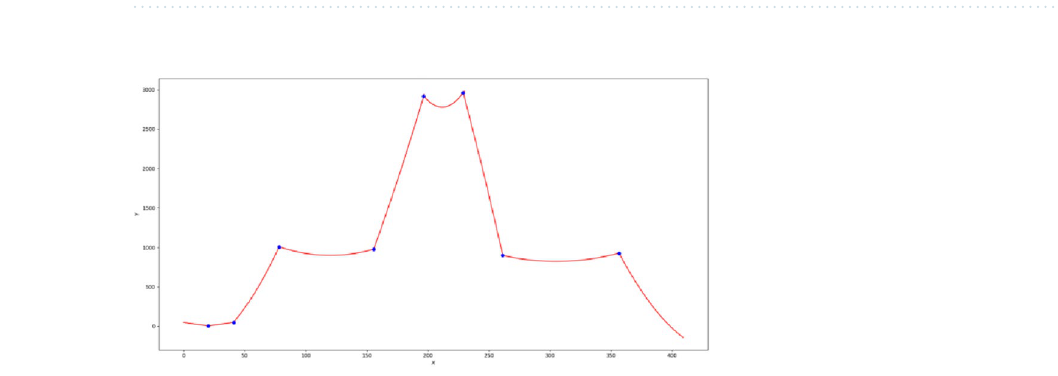
Figure 4. Parts of four types small fishing vessels data. ( a ) Small alloy fishing vessels, ( b ) wooden fishing vessels, ( c ) rubber inflatable fishing vessels, ( d ) PE plastic fishing vessels.